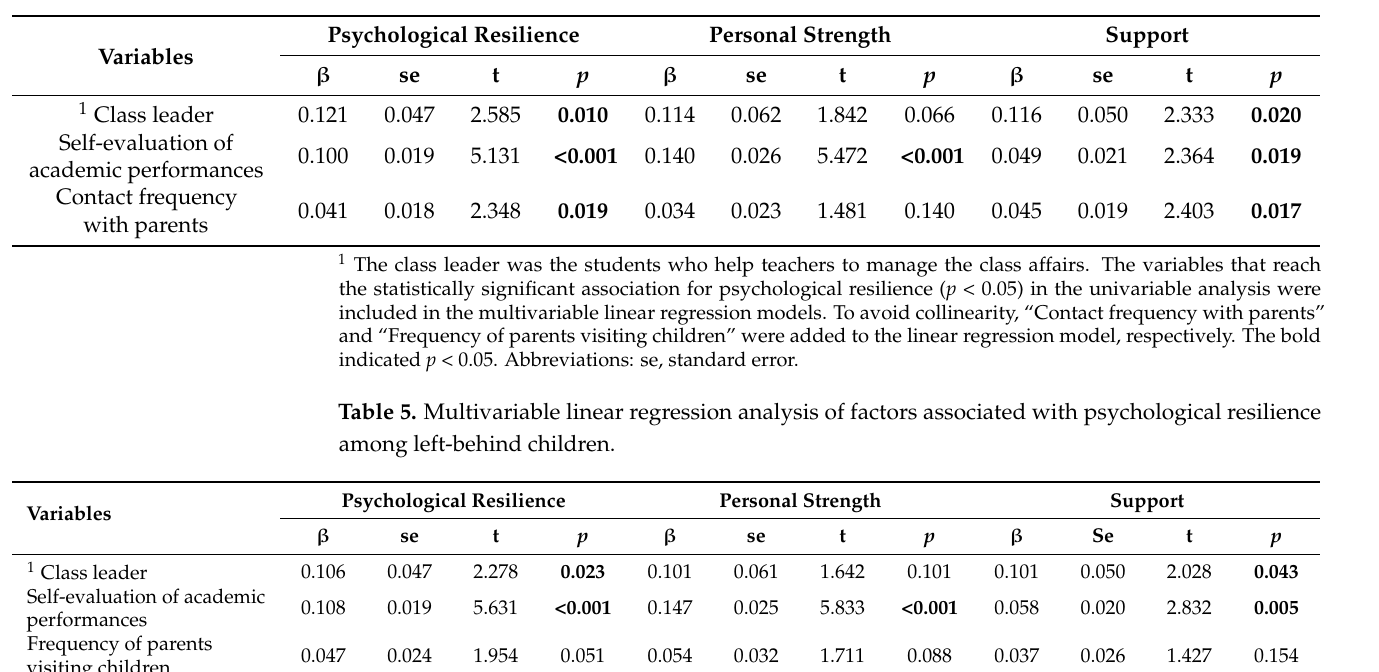
Table 4. Multivariable linear regression analysis of factors associated with psychological resilience among left-behind children.